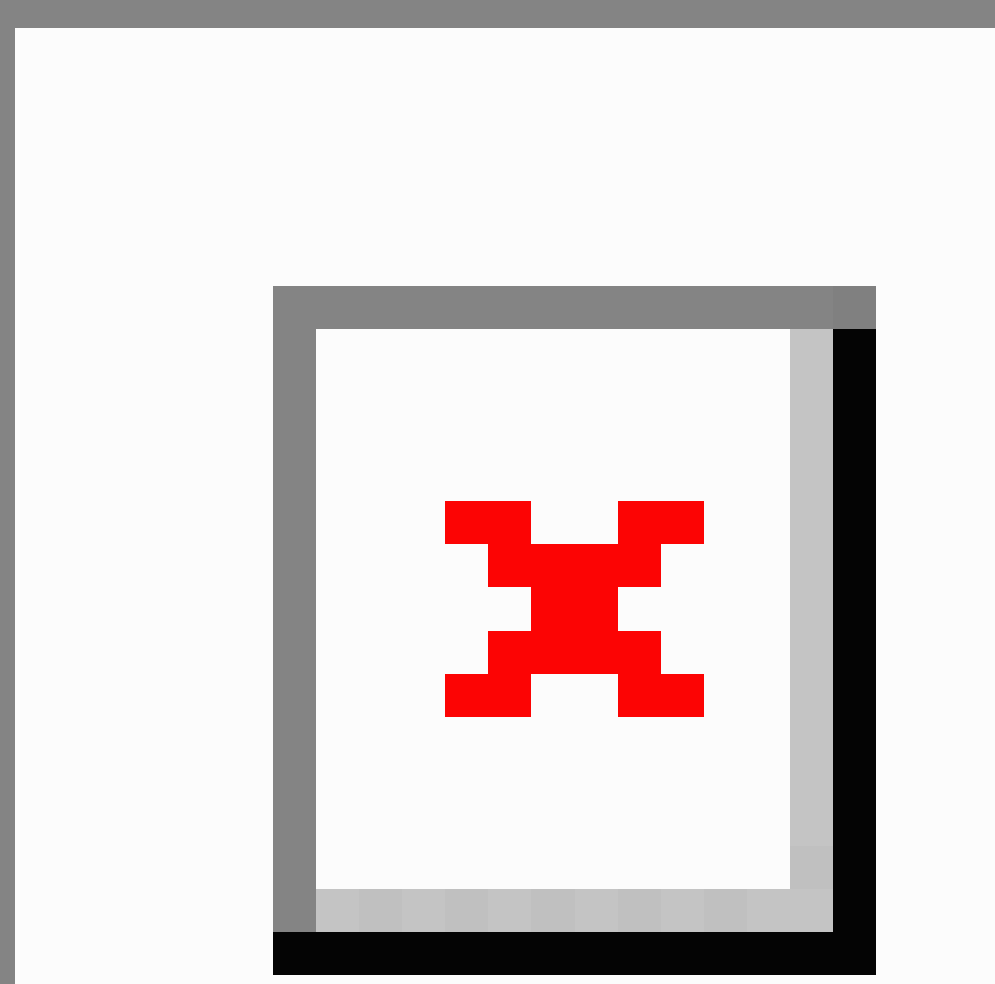
Figure 1. Sample page from the initial wireframe shown to the multidisciplinary team and patient advisers for